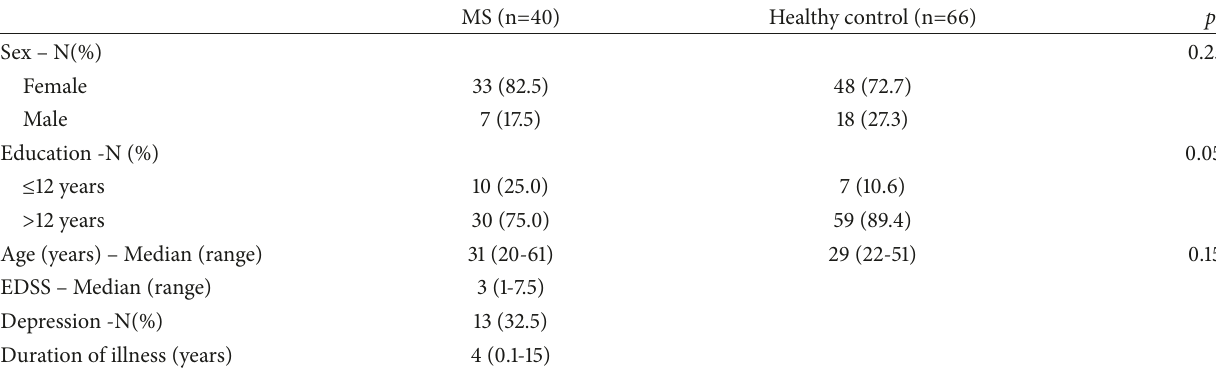
Table 1: Demographic and clinical characteristics of MS and healthy control